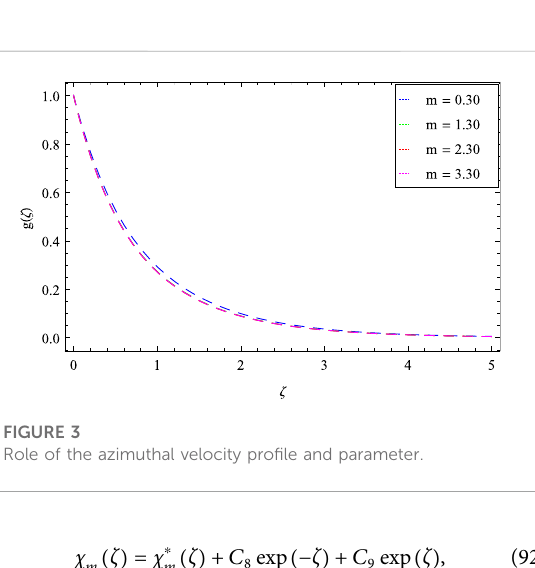
FIGURE 2 Role of the radial velocity pro fi le and parameter.